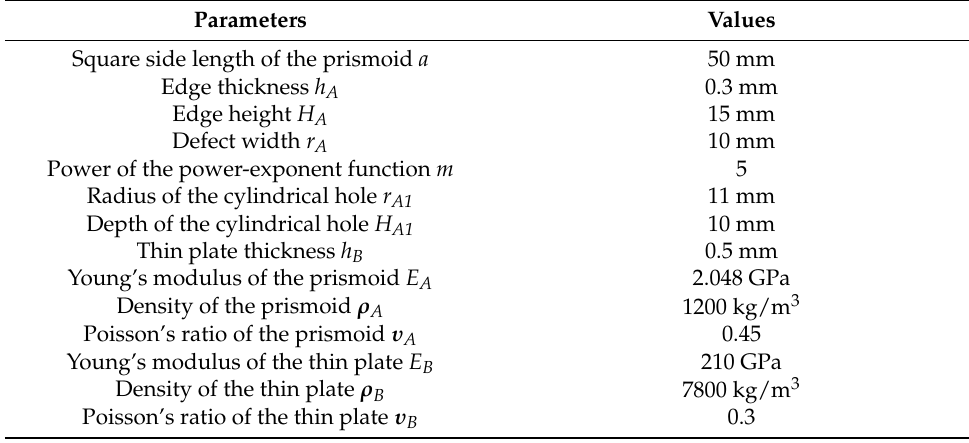
Figure 3. Irreducible region of the Brillouin zone of the phononic crystal. Table 1. Geometrical and material parameters of the phononic crystal.